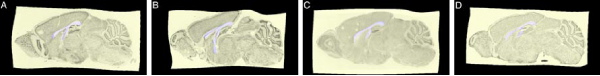
Examples of anatomical structure expression extraction.  Gene expression images with hippocampus mask overlaid in blue.  Corresponding genes are A. Abr, B. Aplp2, C. Aff2, D. App. For a given pixel intensity value I, expression values are calculated via  (256-I)/256. The 75 percentile of expression values of all pixels in a  mask are then used as the expression statistic.